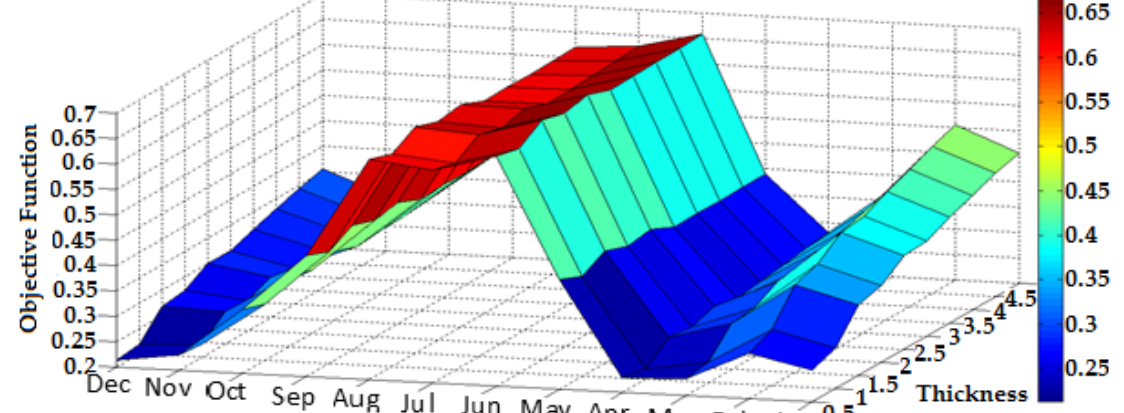
Figure 7. Objective function for the PU insulation.